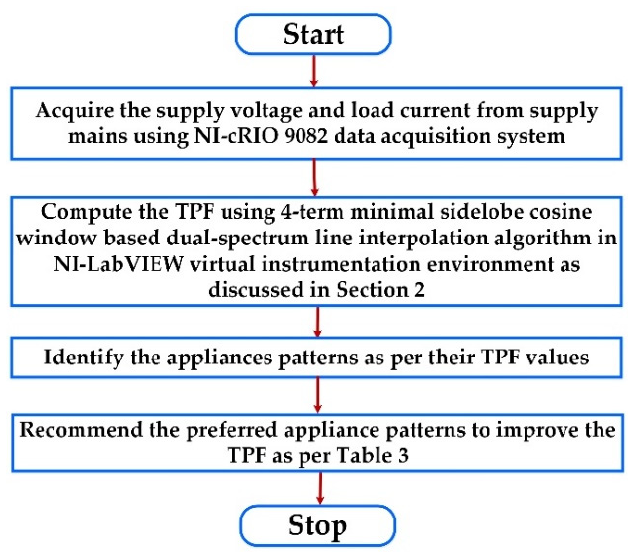
Figure 4. Flowchart for the non-intrusive identification of appliance usage patterns with the TPF.